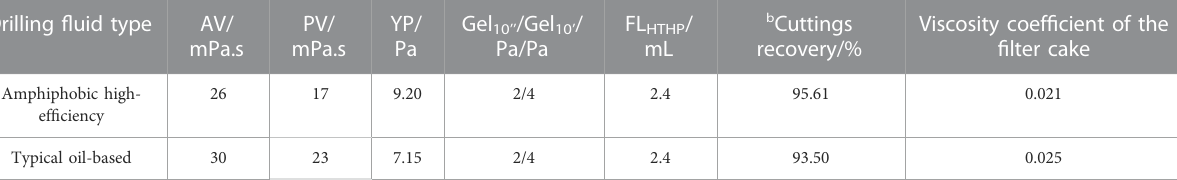
TABLE10Performancecomparison(after a hot-rolling)betweentheamphiphobichigh-ef fi ciencyPDFandtypicaloil-baseddrilling fl uid (density is1.4 g/cm 3 ). Drilling fl uid